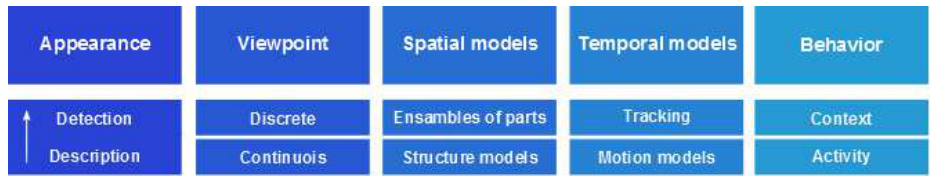
Figure 1. Proposed taxonomy for model-based Human Pose Recovery